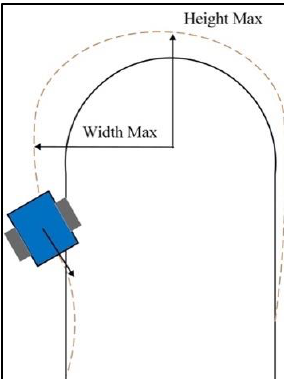
Figure 12. Performance in the headland turning experiment. ( a ) First part; ( b ) second part; ( c ) third part.